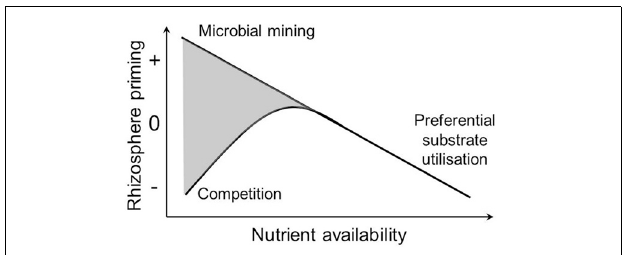
FIGURE 1 | Hypothetical relationship between soil nutrient availability and rhizosphere priming. Three nutrient-centered hypotheses are illustrated: Microbial mining: microbes utilize rhizodeposition to mine for nutrients in SOM thereby causing a positive rhizosphere priming effect when nutrient availability is low; Preferential substrate utilization: microbes switch from decomposing SOM to utilizing rhizodeposition when nutrient availability is high; Competition: microbes compete for nutrients with plants causing a negative rhizosphere priming effect because microbial growth and decomposition are nutrient limited. Both positive and negative rhizosphere priming can occur under low nutrient availability (gray